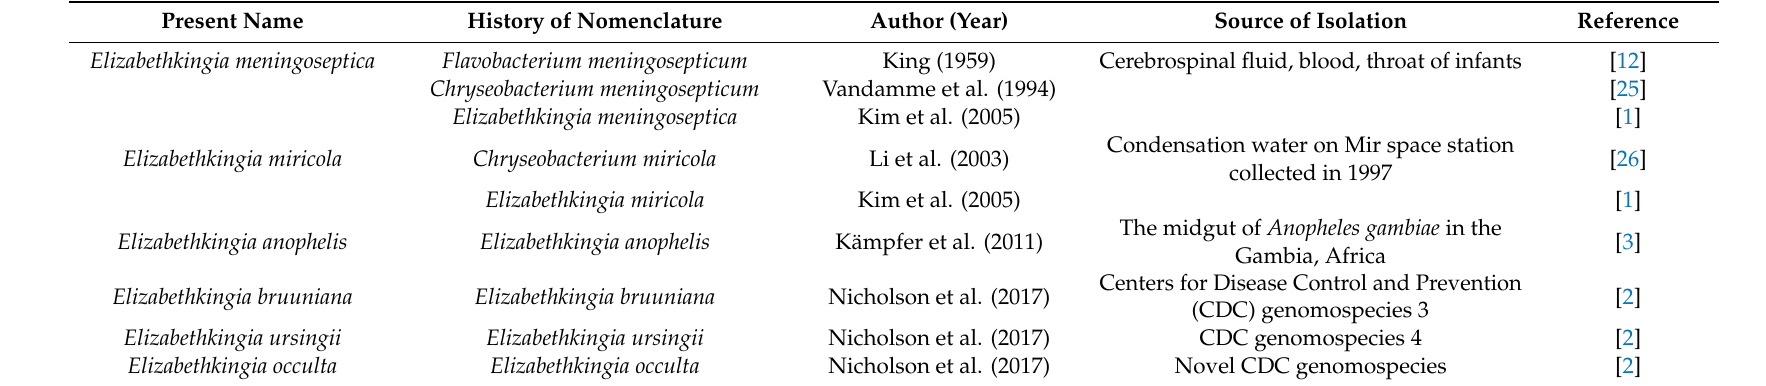
Table 1. Taxonomy and nomenclature of Elizabethkingia